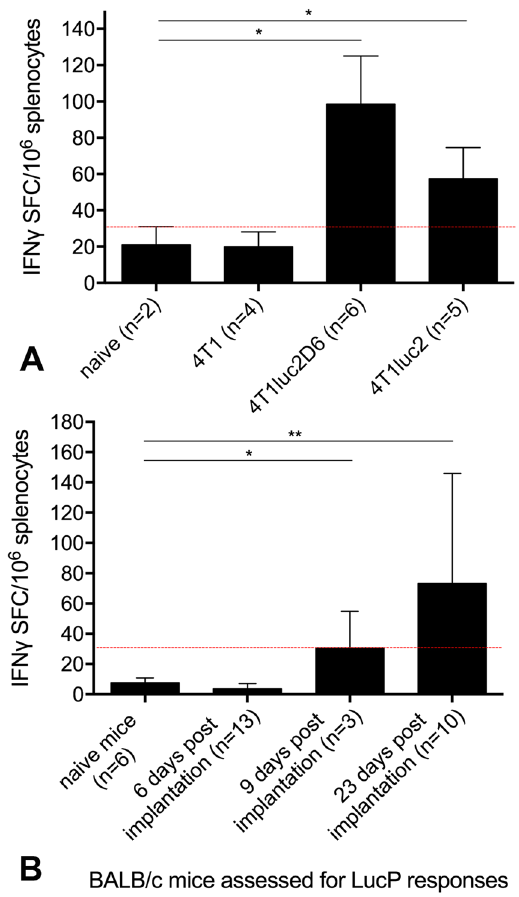
Figure 7. In vitro IFN-gamma response of lymphocytes of BALB/c mice implanted with Luc-expressing 4T1luc2D6 or 4Tl1luc2, or parental 4T1 cells, to stimulation with peptide GFQSMYTFV representing an immunodominant CTL epitope of luciferase (LucP) assessed using IFN- γ ELISpot (Mabtech). IFN- γ response to LucP by the experimental end-point assessed as the average number of IFN- γ spot forming cells per mln splenocytes (SFC/mln) with STDV; * p < 0.05, IFN- γ response to LucP in BALB/c mice implanted with 4T1luc2D6 and 4T1luc2 cells compared to IFN- γ response exhibited by naïve or 4T1-implanted mice (Mann- Whitney test) ( A ); Development of cellular immune response to LucP in mice implanted with 5000 4T1luc2 cells, on days 6, 9 and 23 post implantation; * p < 0.05, IFN- γ response to LucP in BALB/c mice implanted with 4T1luc2 cells on days 9 and 23 post implantation compared to IFN- γ response exhibited by naïve mice or mice implanted by 4T1luc2 and assessed on day 6 post implantation (Friedman ANOVA and Kendall Coeff. of Concordance) ( B ). Red line indicates the cut-off for the specific IFN- γ response, defined as an average number of lymphocytes producing IFN- γ in response to stimulation with LucP ± 3 STDV per mln lymphocytes. Cut-off was established in independent in vitro tests done on splenocytes of naïve mice (n =